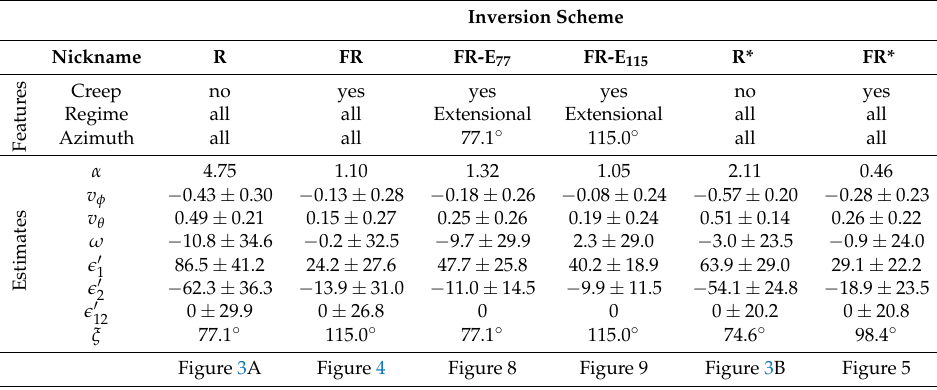
Table 3. The mean estimates and standard deviations of the east, v φ , and north, v θ , components of the regional velocity (in mm/yr) at the the reference point ( 16.23 ◦ ,39.81 ◦ ) , of the rotation rate, ω (in 10 − 9 /yr) and of the mean components of the deviatoric strain rates (cid:101) (cid:48) with respect to the two horizontal principal axes, (cid:101) (cid:48) for the different case of GNSS data inversion considered in the main text, with and without fault creep and with prior information about the tectonic regime and the azimuth of the direction of maximum extension, ξ . For the inversion schemes R* and FR* the CIVI station is not